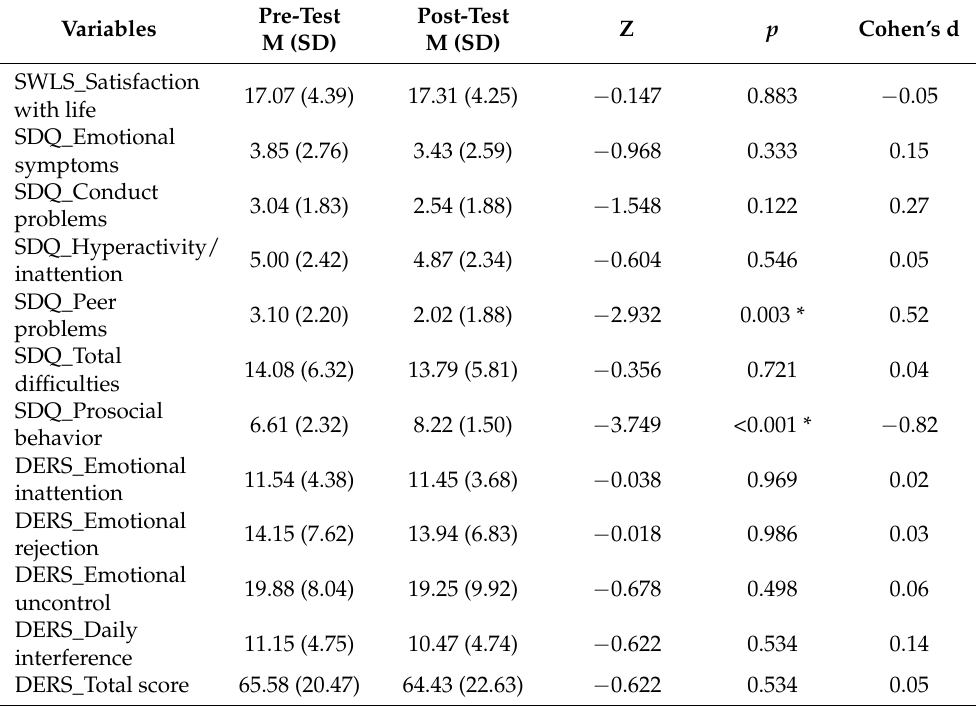
Table 4. Pre- to post-changes and effect sizes after one academic year of DBT STEPS-A (n =